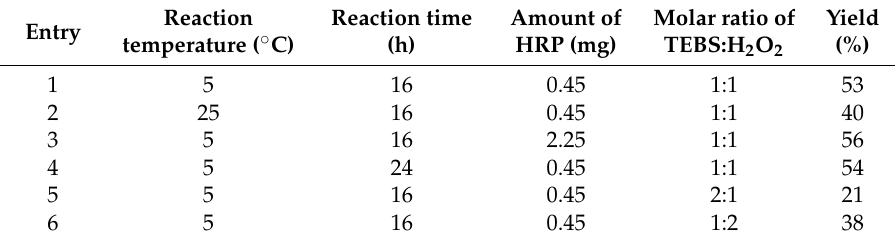
Table 1. Enzyme-catalyzed polymerization of TEBS at different reaction conditions 1 .